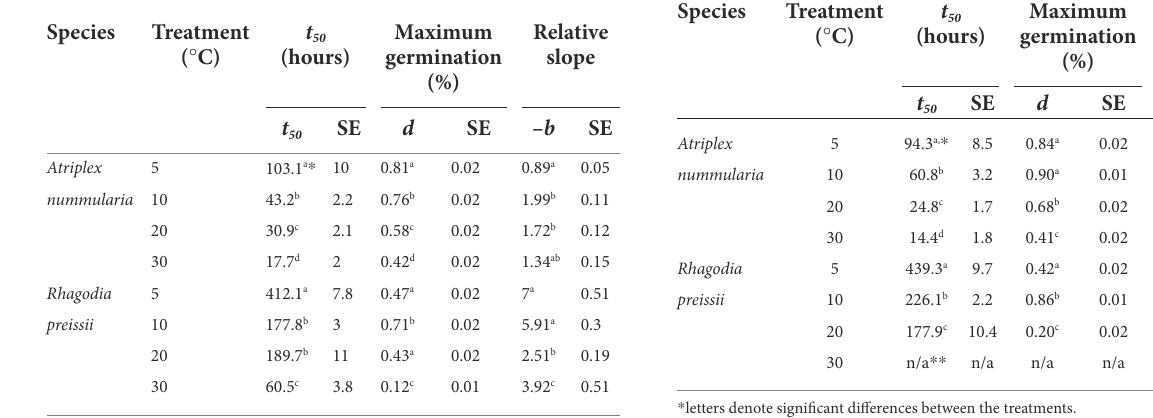
TABLE 3 Temperature experiment 1B: influence of temperature on seed germination of A. nummularia and R. preissii under four constant temperatures, expressed by the estimated parameters and associated SE from the log-logistic model (1) applied to the